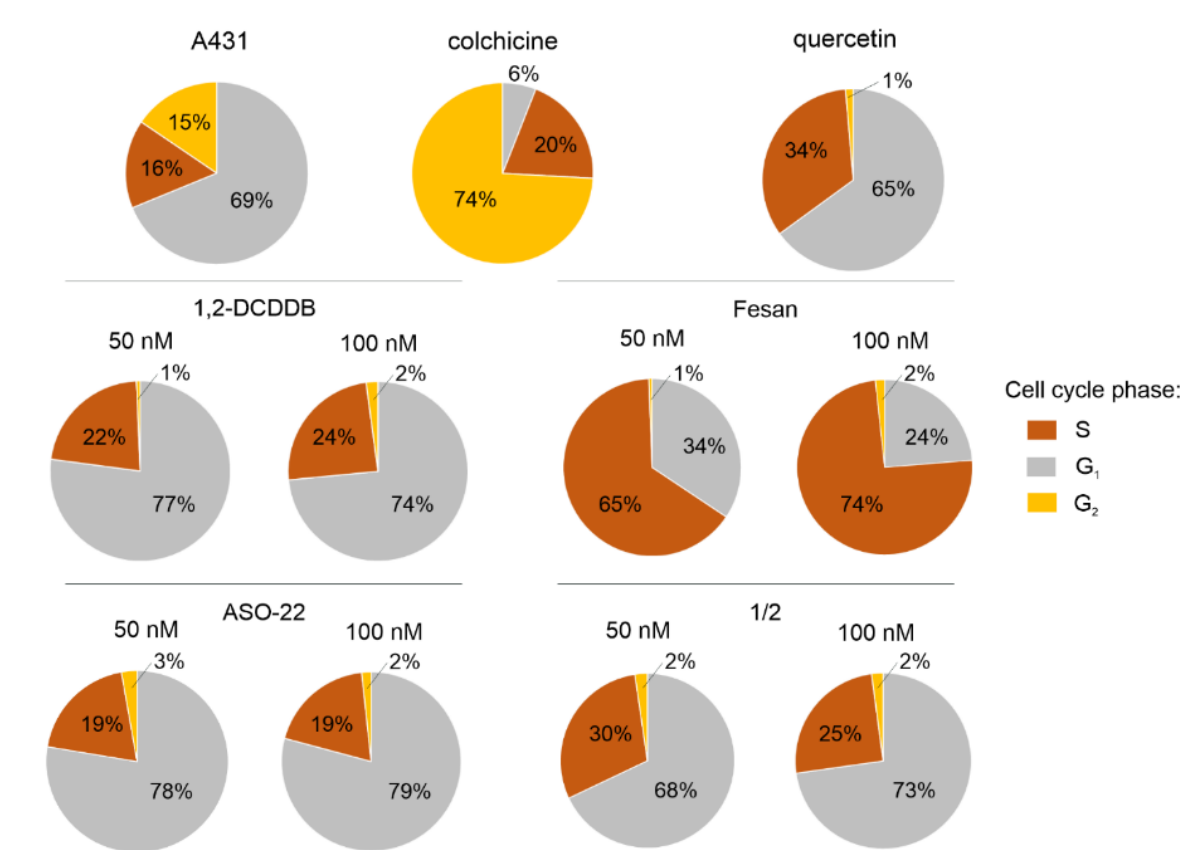
Figure 6. FACS analysis of the cell cycle phases of A431 cells upon Lipofectamine 2000-assisted transfection with ASO-22 and nanostructures 1/2 (50 and 100 nM) after 48 h of incubation, and for A431 cells treated with 1,2-DCDDB and FESAN (50 and 100 nM). The A431 cells treated with Lipofectamine 2000 only were used as a control. Colchicine and quercetin were used as positive controls.